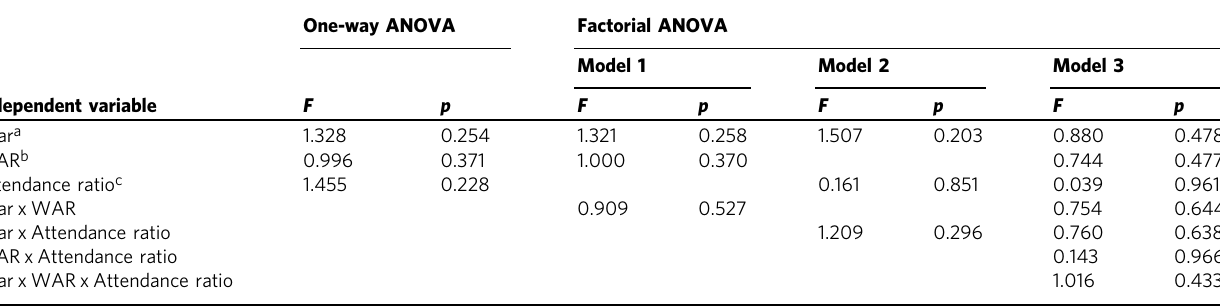
Table 4 Results of one-way and factorial ANOVA of the relative home advantage in Major League Baseball, 2015 – 2020 seasons ( n = 180